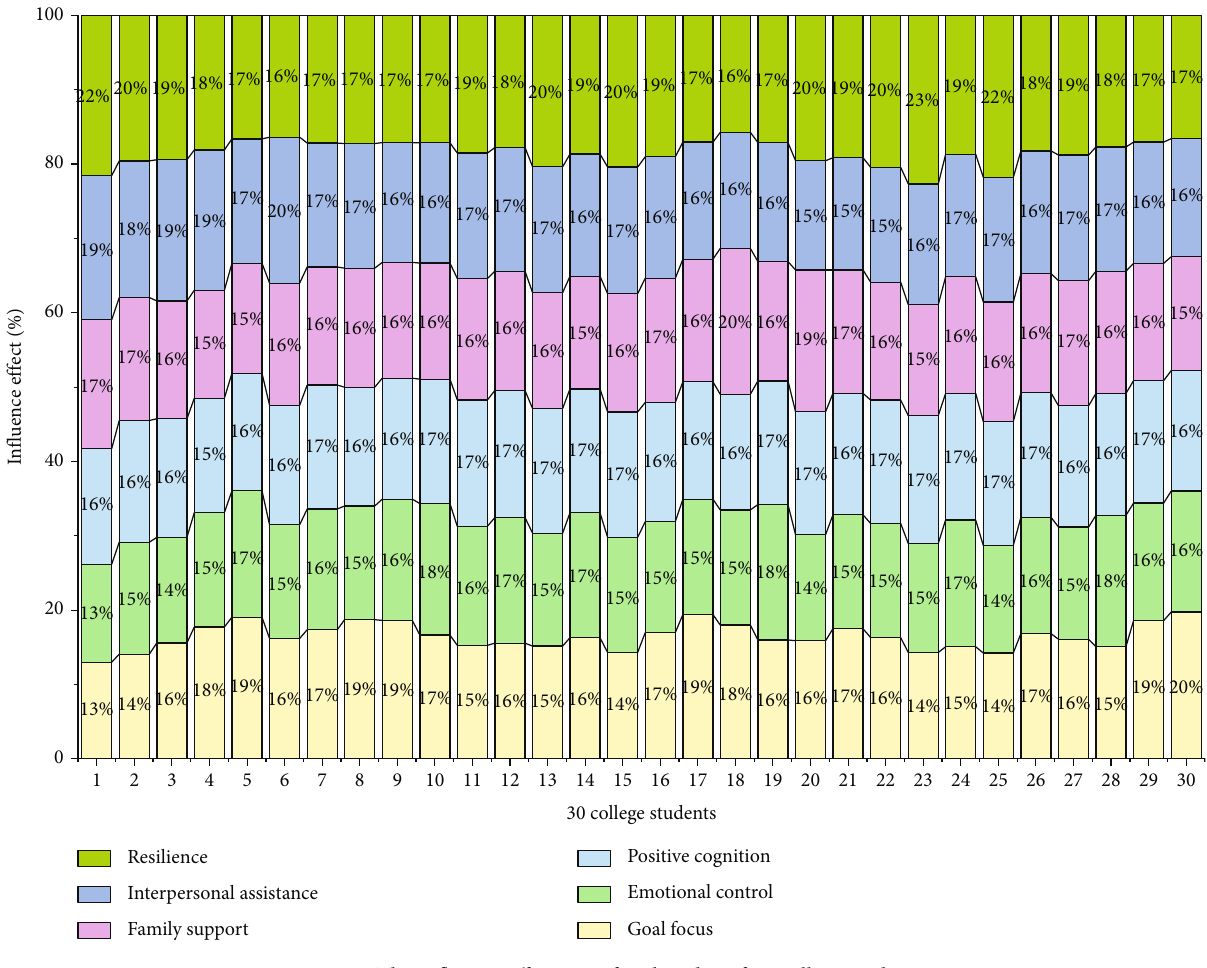
Figure 4: The in fl uence e ff ect test of each index of 30 college students. Table 1: Factor evaluation and analysis of one-to-one training in psychotherapy.